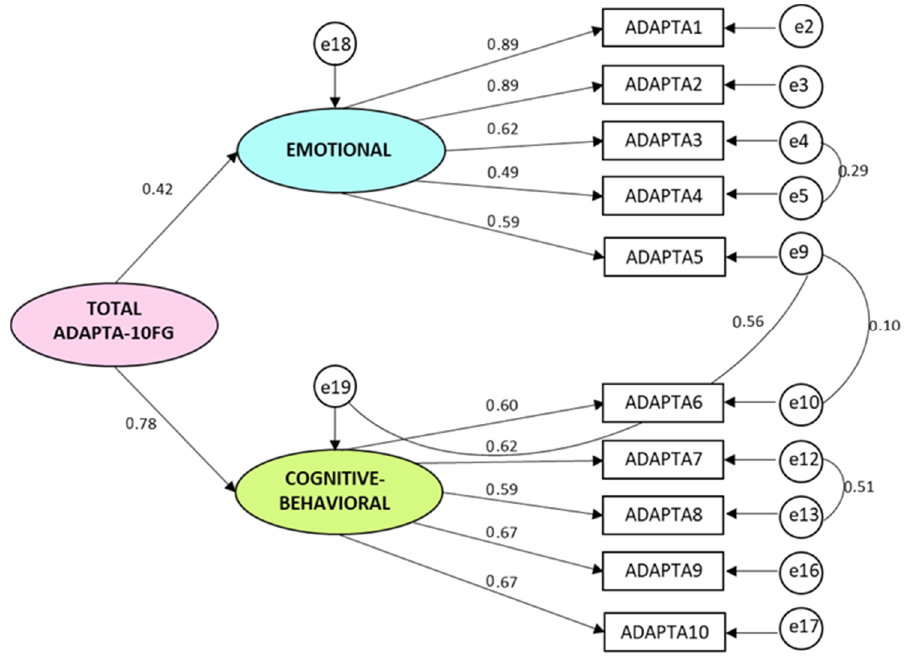
Figure 1. Confirmatory Factor Analysis ADAPTA-10FG Model.